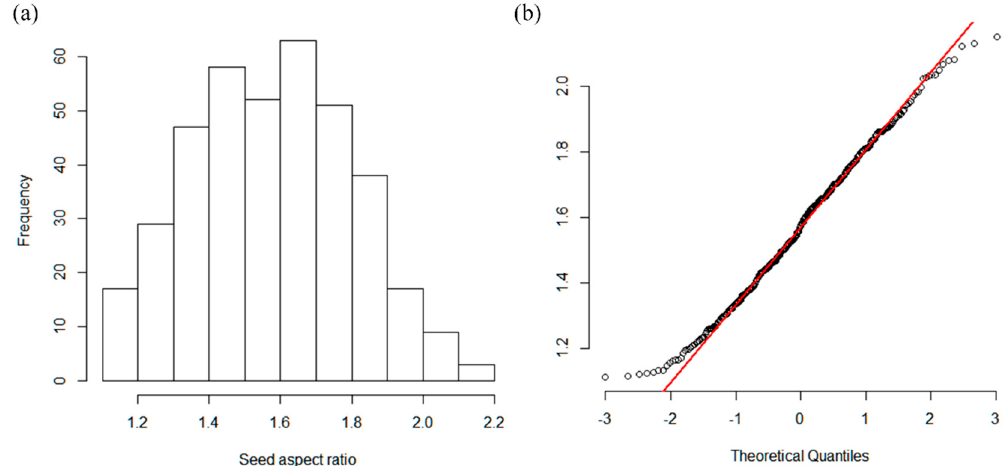
Figure 2. ( a ) Peanut seed aspect ratio data histogram; ( b ) The normal distribution test by the quantile-quantile (QQ plot) graph.